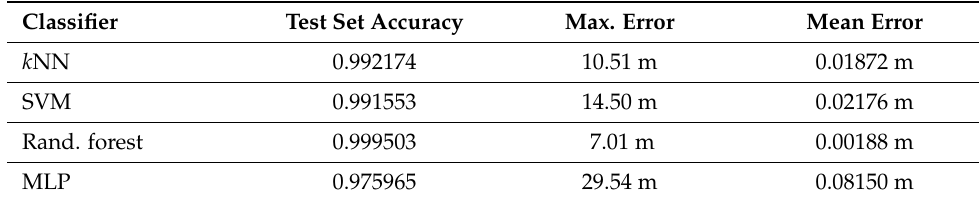
Table 3. Summary of classifier performance in the two-dimensional classification